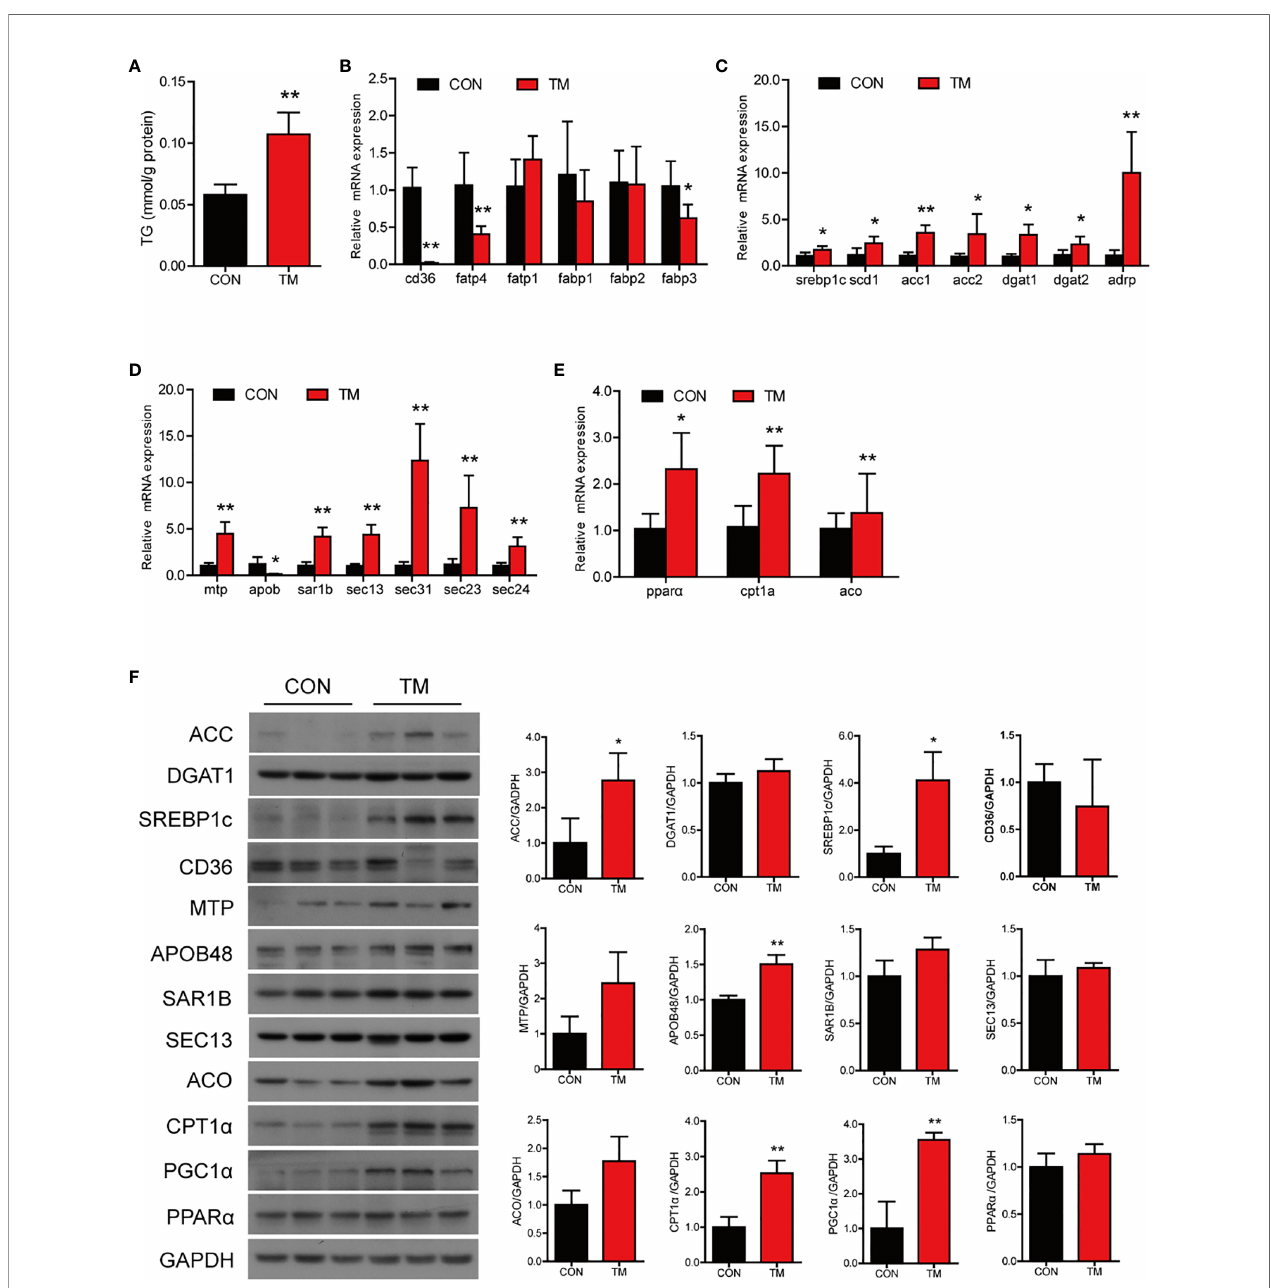
FIGURE 2 | ER stress disrupts lipid metabolism homeostasis in the intestine of large yellow croaker in vivo . (A) TG content in the intestine of large yellow croaker after TM injection for 24 h (n = 6). Relative mRNA expression of fatty acid uptake (B) , lipid synthesis (C) , chylomicron secretion (D), and fatty acid b -oxidation (E) in the intestine of large yellow croaker after TM injection for 24 h (n = 6). (F) Western blot analysis of lipid metabolism related protein levels in the intestine of large yellow croaker after TM injection for 24 h (normalized to GAPDH, n = 3). cd36 , fatty acid translocase; fatp1 , fatty acid transport protein 1; fatp4 , fatty acid transport protein 4; fabp1 , fatty acid-binding protein 1; fabp2 , fatty acid-binding protein 2; fabp3 , fatty acid-binding protein 3; srebp1c , sterol regulatory element binding protein 1 c; scd1 , stearoyl-CoA desaturase 1; acc1 , acetyl-CoA carboxylase 1; acc2 , acetyl-CoA carboxylase 2; dgat1 , diacylglycerol acyltransferase 1; dgat2 , diacylglycerol acyltransferase 2; adrp , adipose differentiation-related protein; mtp , microsomal triglyceride transfer protein; apob , apolipoprotein; sar1b , secretion associated Ras related GTPase 1B; sec13 , sec13 homolog, nuclear pore and COPII coat complex component; sec31 , sec31 homolog A, COPII coat complex component; sec23 , sec23 homolog A, coat complex II component; sec24 , sec24 homolog A, COPII coat complex component; ppar a , peroxisome proliferator-activated receptor alpha; cpt1 a , carnitine palmitoyl transferase 1 alpha; aco , acyl-CoA oxidase; PGC1 a , peroxisome proliferator-activated receptor gamma coactivator 1alpha; GAPDH, glyceraldehyde-3- phosphate dehydrogenase. Results were analyzed using independent t -test (* P < 0.05, ** P < 0.01), and they were presented as mean ± standard